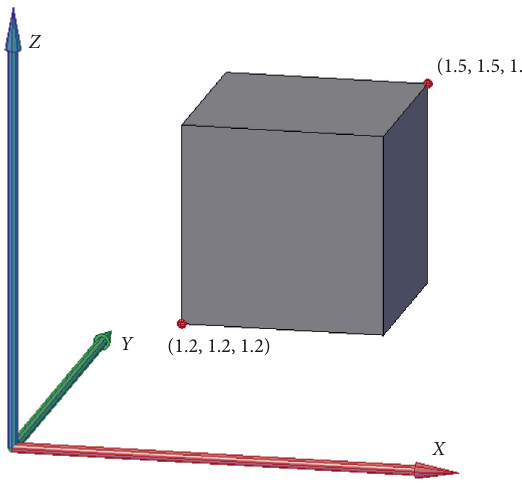
Figure 2: Obstruction positioned by two diagonal